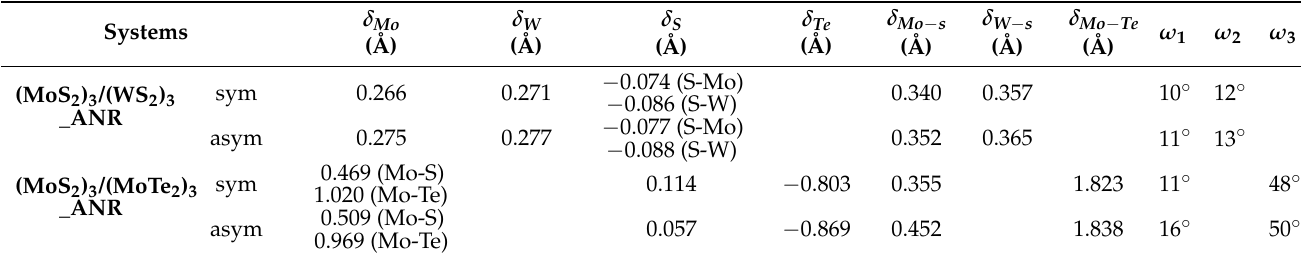
Figure 9. The relaxed geometries of 7-ac-(MoS 2 ) 3 /(MoTe 2 ) 3 -NR-sym ( a ) and 8-ac-(MoS 2 ) 3 /(MoTe 2 ) 3 -NR-asym ( b ). 𝛿 (cid:3014)(cid:3042) , δ (cid:2903) , 𝛿 (cid:3021)(cid:3032) are the vertical displacements of the edge-layer Mo, S, Te atoms relative to unrelaxed structures, respectively. ω 1 and ω 3 are the tilt angles for the Mo-S and Mo-Te bonds from the horizontal line.